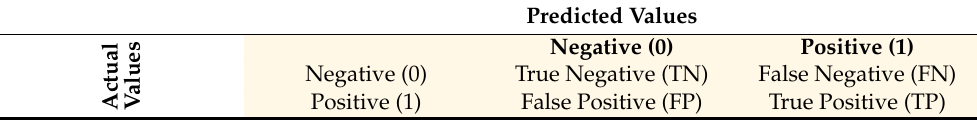
Table 3. Actual Values against Predicted